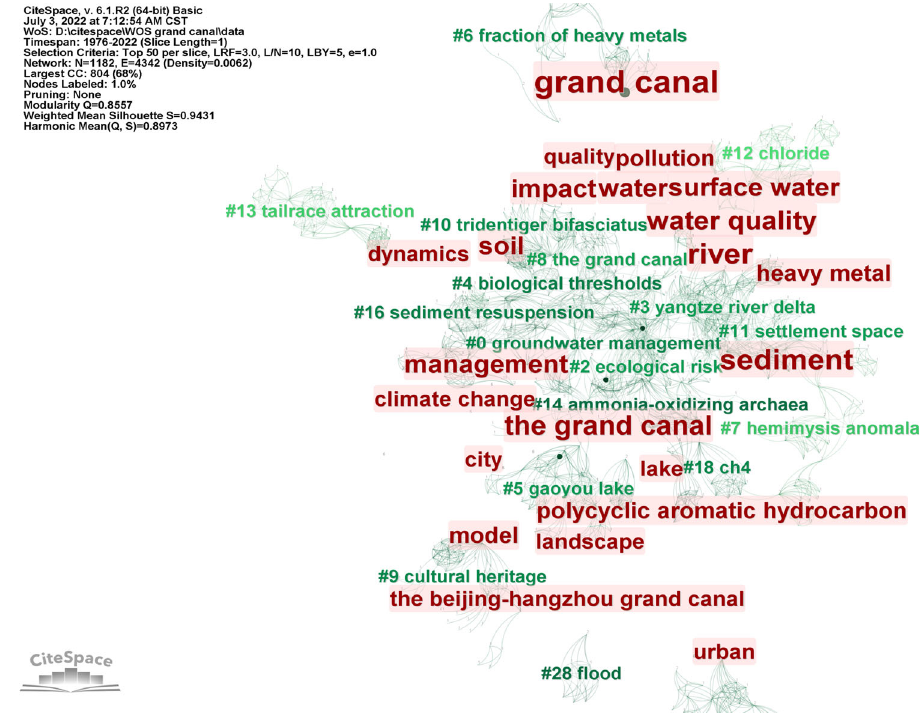
Fig. 2 Keywords and knowledge clusters of grand canal literatures in WoS database (1976 –